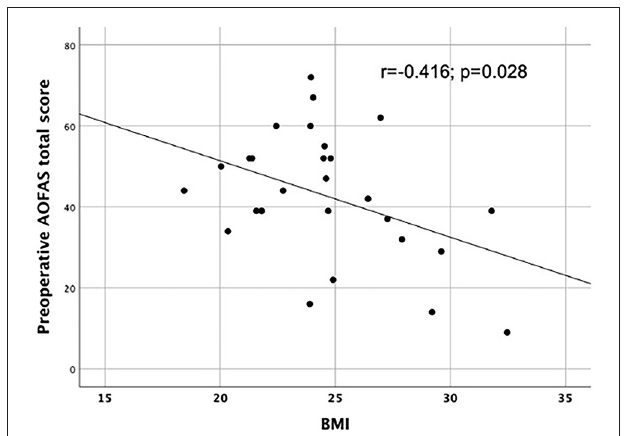
FIGURE 2 | Correlation between AOFAS total scores and BMI in the whole